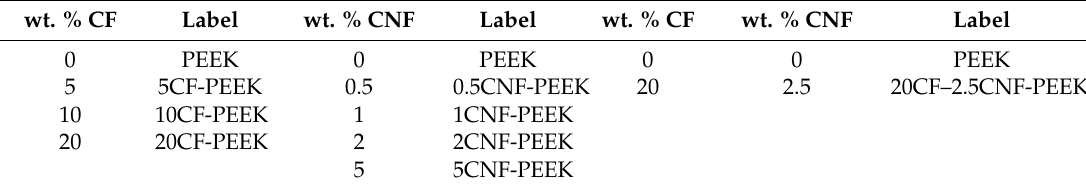
Table 1. Carbon fiber (CF), carbon nanofiber (CNF), and CF–CNF-reinforced PEEK Composites Produced. wt. %